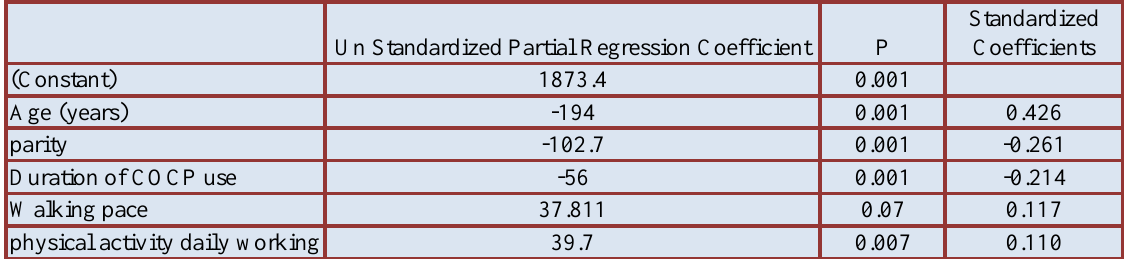
Table3: The effect of COCP on cortical thickness of Gonial angle after adjusting with other